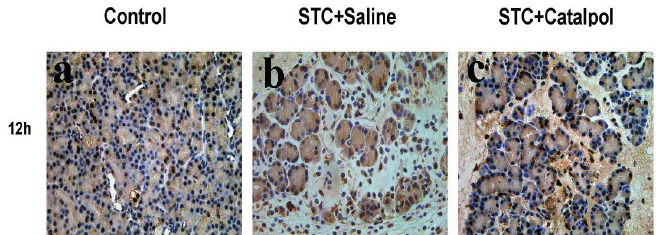
Figure 6. Immunohistochemical analysis to detect NF-  B expression at three time-points in each group. Control group at three time-points ( a , d , g ); STC+saline-treated group at the three time-points ( b , e , h ); STC+catalpol-treated group at the three time-points ( c , f , i ). Original magnification: ×400, all specimens were observed by three pathologists unaware of their origin. Results are representative of three independent